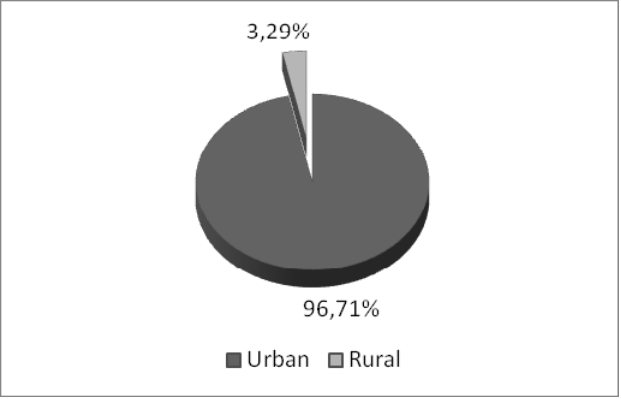
Figure 7. State of Rio de Janeiro: population distribution in accordance with urban and rural areas